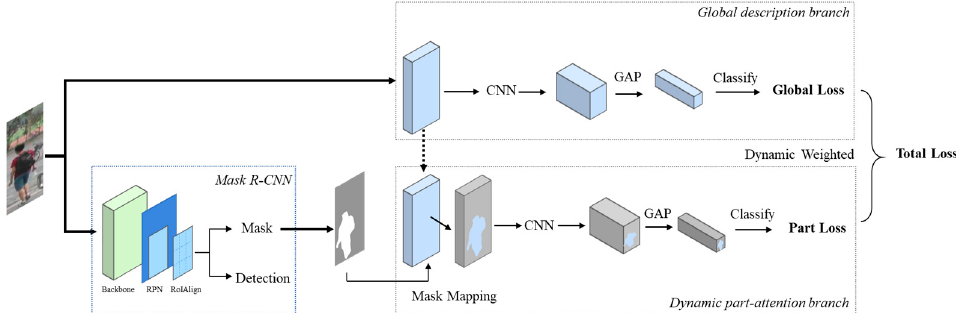
Figure 3. The framework of the proposed dynamic part attention (DPA) method for person ReID. RGB images are the inputs. We first use Mask R-CNN segment body masks. Then the main framework consists of two branches. In the figure, we first choose the ResNet-50 as the backbone to extract features, then design two branches to estimate total loss. The first branch uses global average pooling (GAP) to calculate the global loss, and the second one uses segmented mask as the attention part to calculate the mask-based part loss. Losses from two branches are combined dynamically for training to